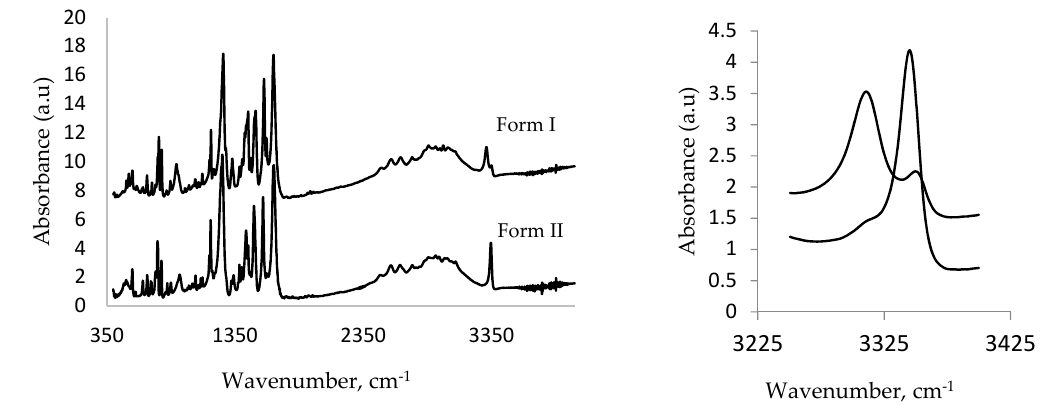
Figure 5. Comparison of IR absorption spectra (400–3500 cm − 1 ) of MA Form I and high-pressure Form II (full spectra left ), zoomed ( right ).